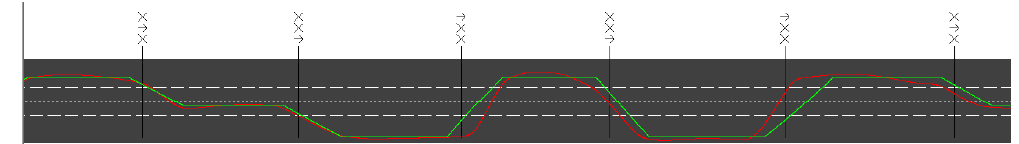
Figure 13. Illustrating calculation of driving performance.